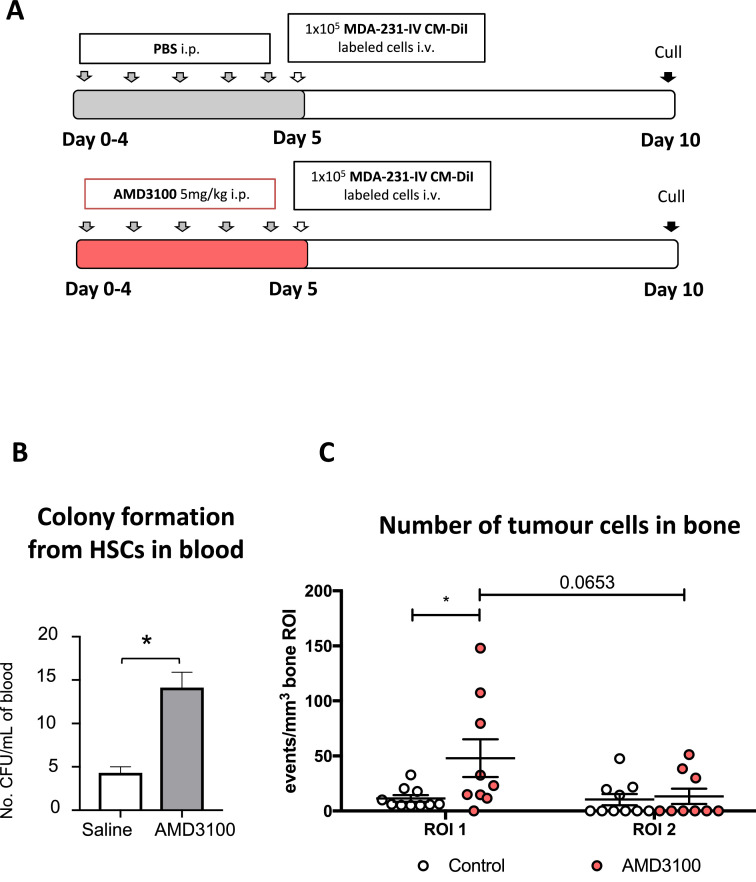
Modification of the HSCs niche – effect on tumour cell homing. (A) Experimental outline of the in vivo study. 12-week old female BALB/c nude mice were injected daily for 5 days with PBS or AMD3100 (5 mg/kg i.p.) (n = 5/group). On day 5, animals were injected with 1 × 105 Vybrant-DiD labelled MDA-MB-231-GFP-IV cells i.v. and culled on day 10, tibias were collected for two-photon microscopy. (B) Ex vivo colony formation by HSC/PCs present in the peripheral blood of 12-week old female BALB/c-Nude mice treated daily for five days with AMD3100 (5 mg/Kg, i.p.) or saline. Graph shows HSC/PCs colony numbers after 11 days of culture ex vivo. (*p<0.05 Mann-Whitney U test; n = 4/group). (C) Graph representing the homing of MDA-MB-231-GFP-IV cells after treatment with the CXCR4 antagonist AMD3100 (n = 9 bones analysed) or with PBS (n = 10 bones analysed). Significantly greater number of tumour cells was detected in ROI1 after the mobilization of the HSCs cells outside the niche. *p ≤ 0.05 two-way ANOVA and Tukey's post-hoc test.